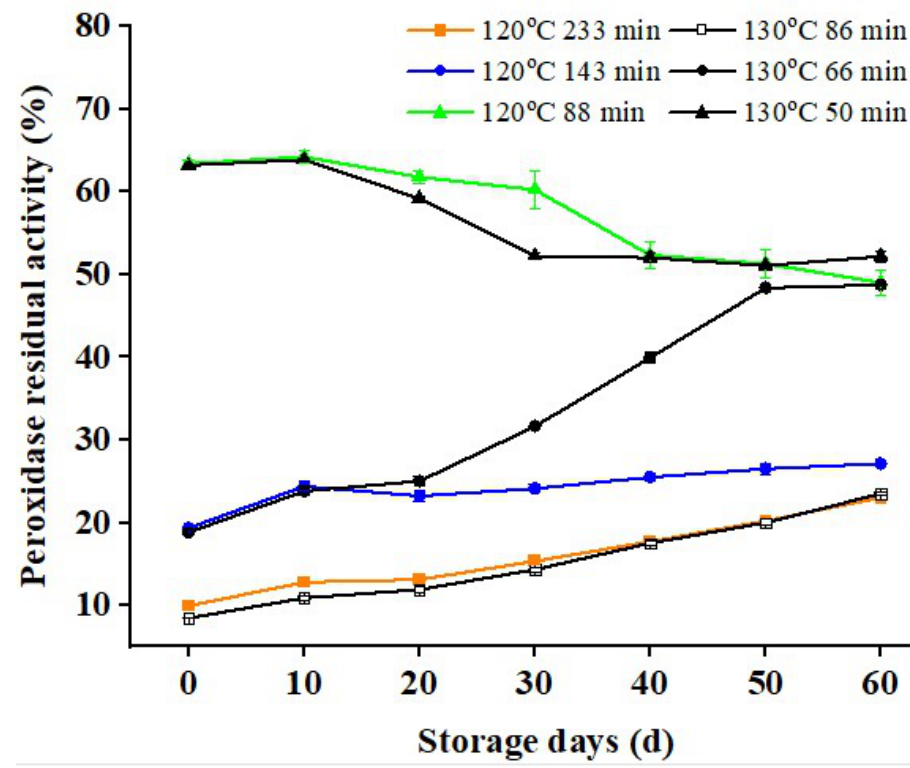
Figure 1. Changes in the residual peroxidase activity of rice bran after dry-heated treatment. Peroxidase residual activity decreased slowly at 120 ◦ C for 88 min and 130 ◦ C for 50 min, whereas it increased at 120 ◦ C for 143 min and 233 min and 130 ◦ C for 66 min and 86 min, indicating an increasing trend in PRA. Gong et al. [25] also observed a slight rise in RPA at 110 ◦ C during the stability of fresh RB. The PRA in RB treated at 120 ◦ C for 233 min, and 130 ◦ C for 66 min increased considerably after 30 days of storage and peaked at 60 days. The increase in peroxide samples indicated that heat pretreatment was effective in